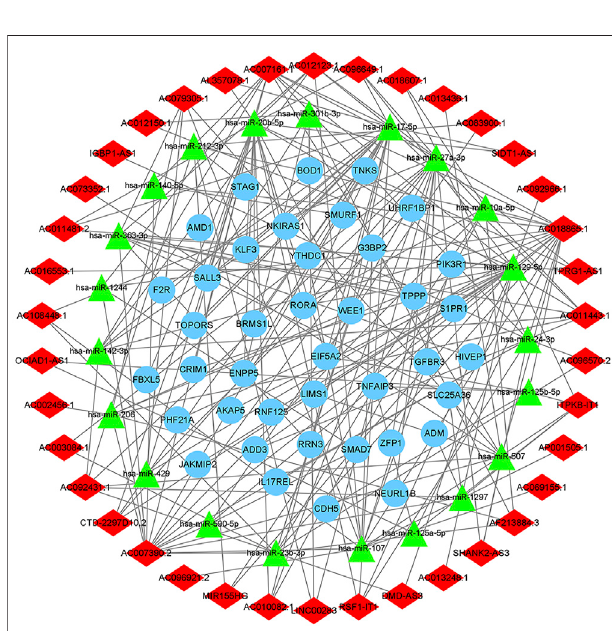
FIGURE 5 | The ceRNA network of lncRNA-miRNA-mRNA. The light blue round nodes, red diamond nodes, and green triangle nodes indicate mRNA, lncRNA, and miRNA,